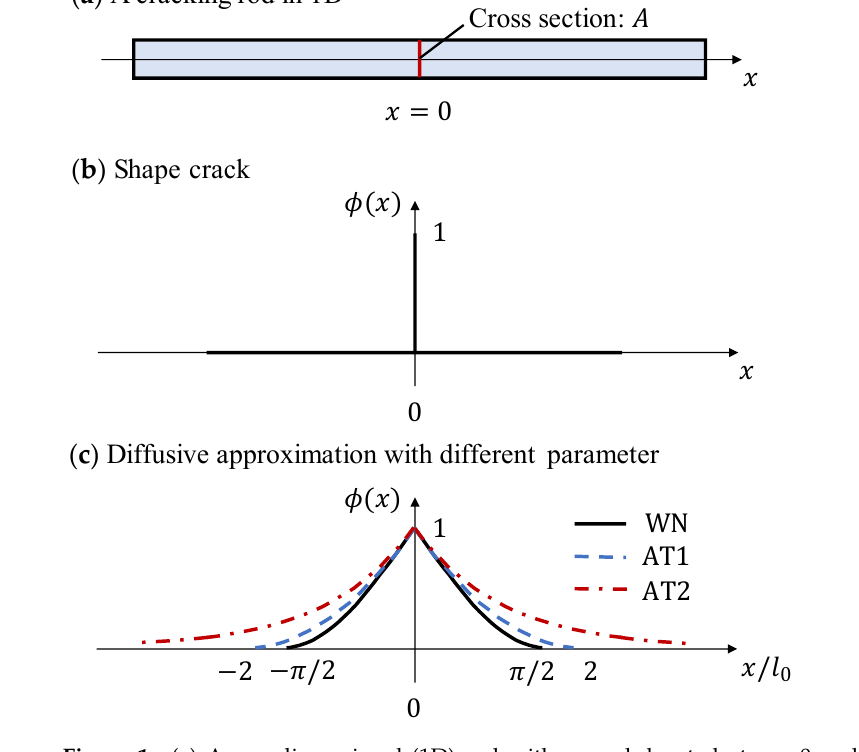
Figure 1. ( a ) A one-dimensional (1D) rod with a crack located at x = 0 and a cross-section A . ( b ) Damage representation with a shape crack at x = 0. ( c ) Diffusive phase field approximation with WN (black), AT1 (blue) and AT2 (red) model scaling by the length scale parameter ℓ 0 .